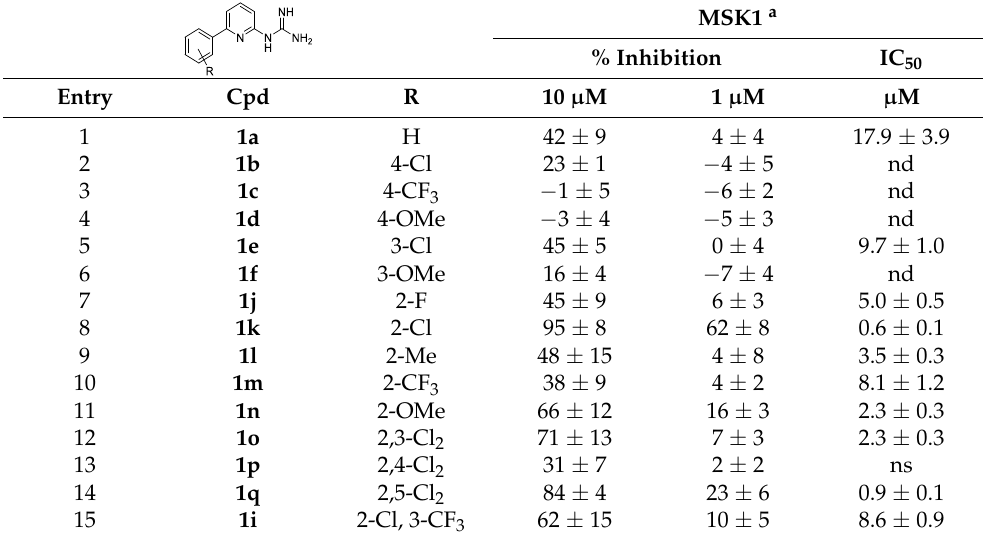
Table 2. Effect of the aromatic substitution at position 6.